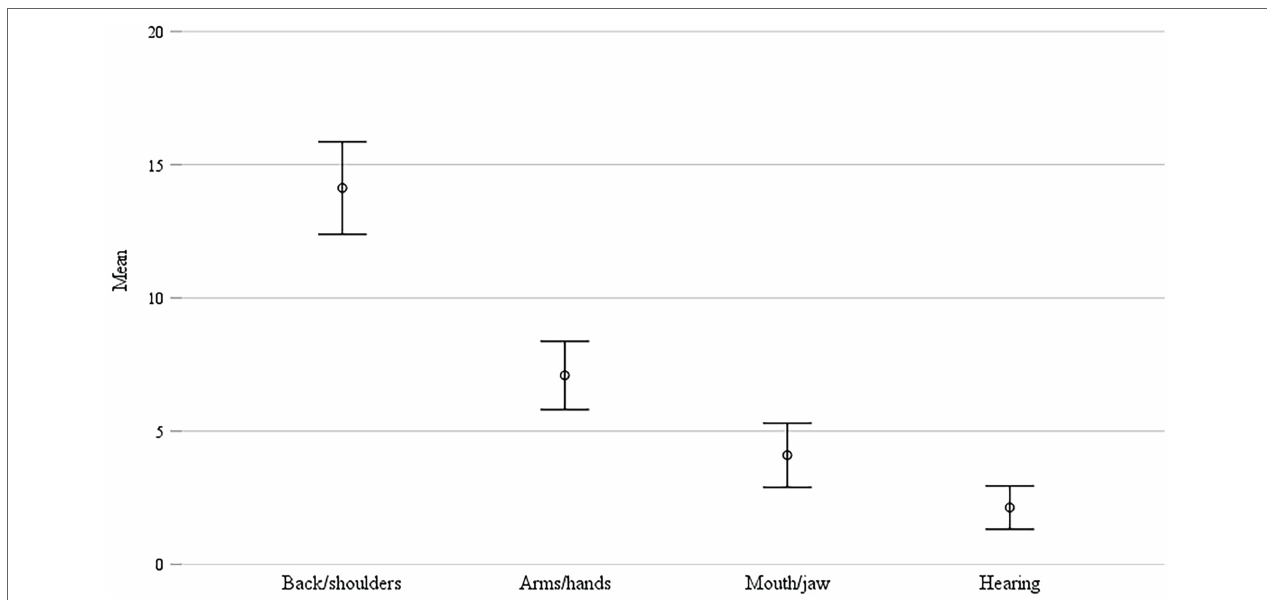
FIGURE 1 | Mean of the pain score (function of frequency and severity of pain; range 0–50) in the respective body parts ( n = 205; error bars represent 95%